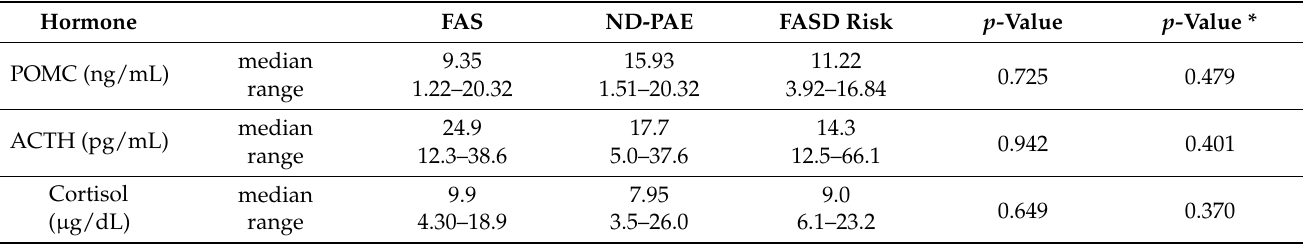
Table 3. Hormone levels in subgroups of patients with FASDs.